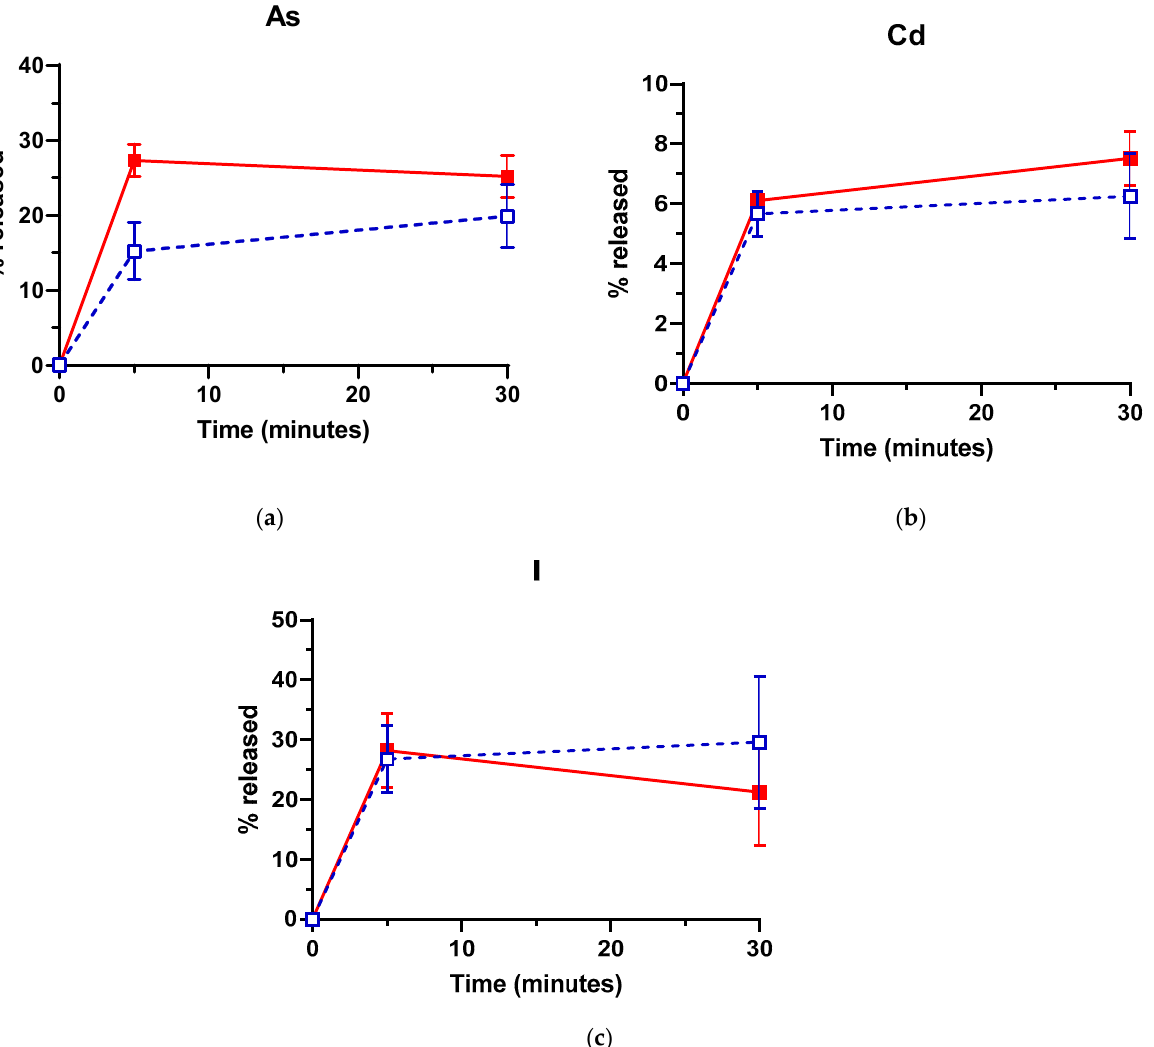
Figure 1. Percentage of arsenic (As) ( a ), cadmium (Cd) ( b ) and iodine (I) ( c ) released from Laminaria hyperborea blades after Ultrasound (US) (red filled symbols, continuous lines) and Control treatments (no US; blue empty symbols, discontinuous lines). Treatment temperature: 50 °C. Error bars correspond to the standard deviations.